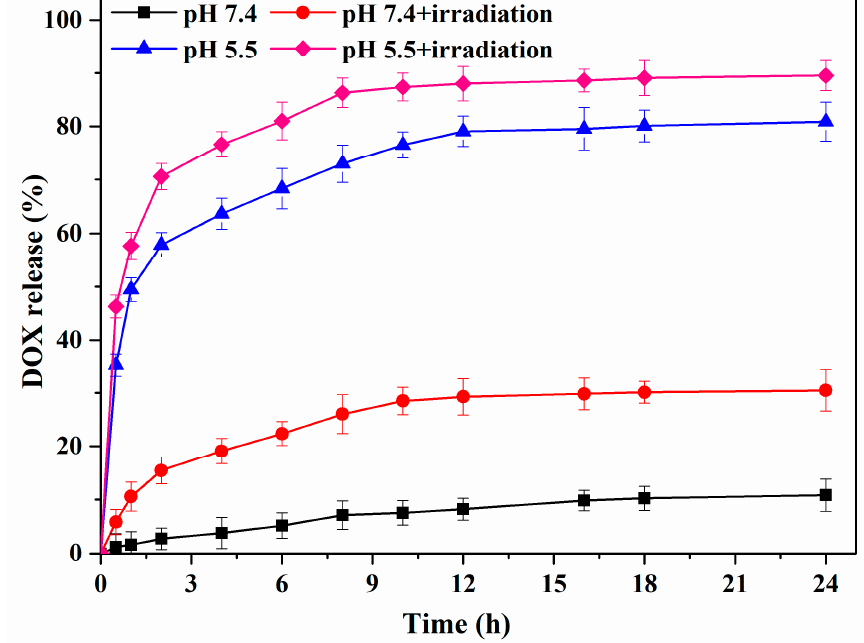
Figure 8. DOX release curves from the mPEG-PEI-(NBS, OA) upconversion nanomicelles with or without irradiation at 980 nm.